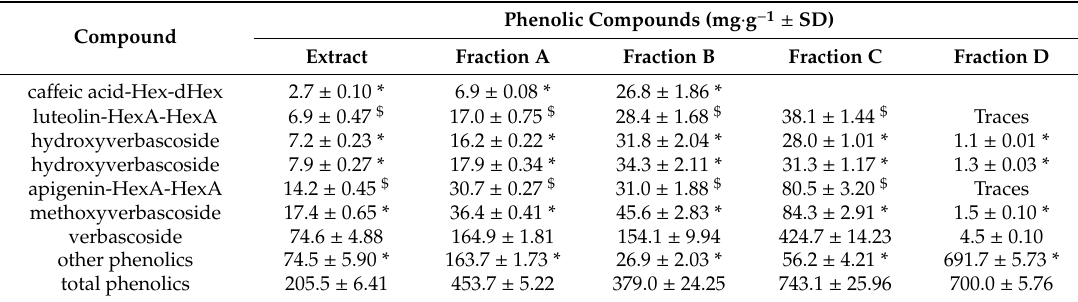
Table 1. Content of phenolic compounds in the extract from Paulownia Clone in Vitro 112, and its fractions.